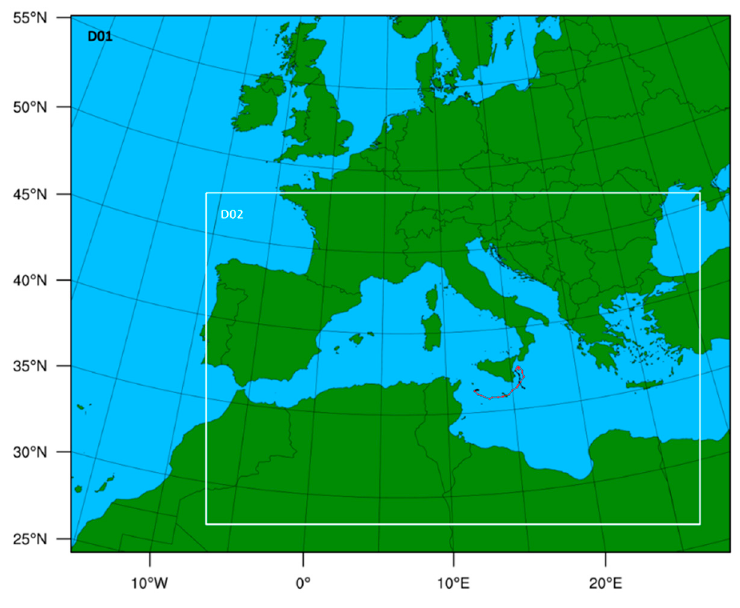
Figure 1. Domains of case study. Table 1. Weather Research and Forecasting (WRF) simulations’ configurations associated with physics parameterization